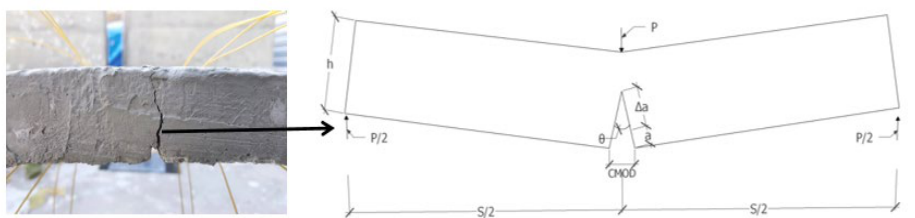
Figure 3. Schematic diagram of segment CMOD.